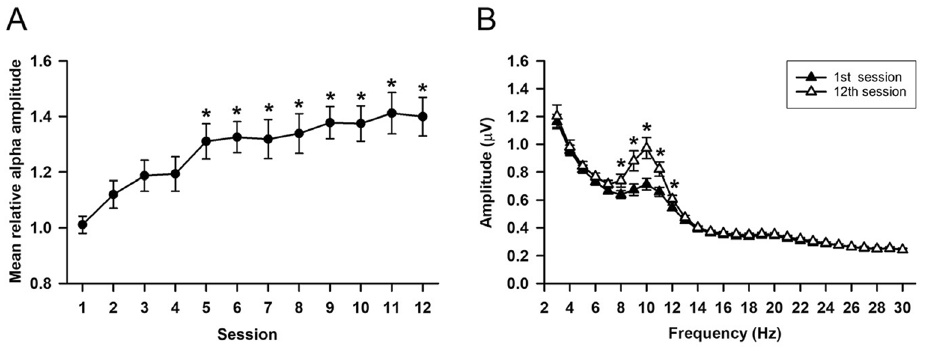
Figure 1. Neurofeedback training (NFT) of upregulation alpha activity. ( A ) The mean relative alpha amplitude (MRAA) throughout 12 NFT sessions. ( B ) Amplitude of 3–30 Hz between the 1st and 12th sessions. The error bars represent the standard error of the mean (SEM). *P < 0.05 vs. 1st